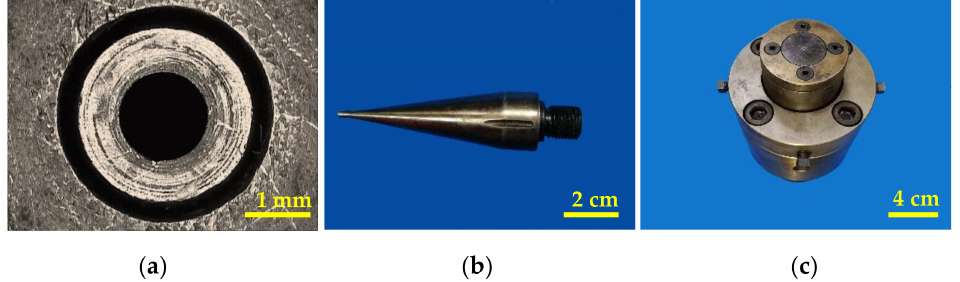
Figure 5. The extrusion die for PLA micro tubes: ( a ) The cross section of extrusion die; ( b ) Mandrel; ( c ) Assembly of extrusion